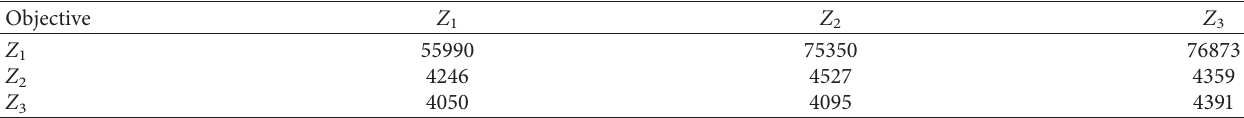
Table 8: Payoff table of three objectives.